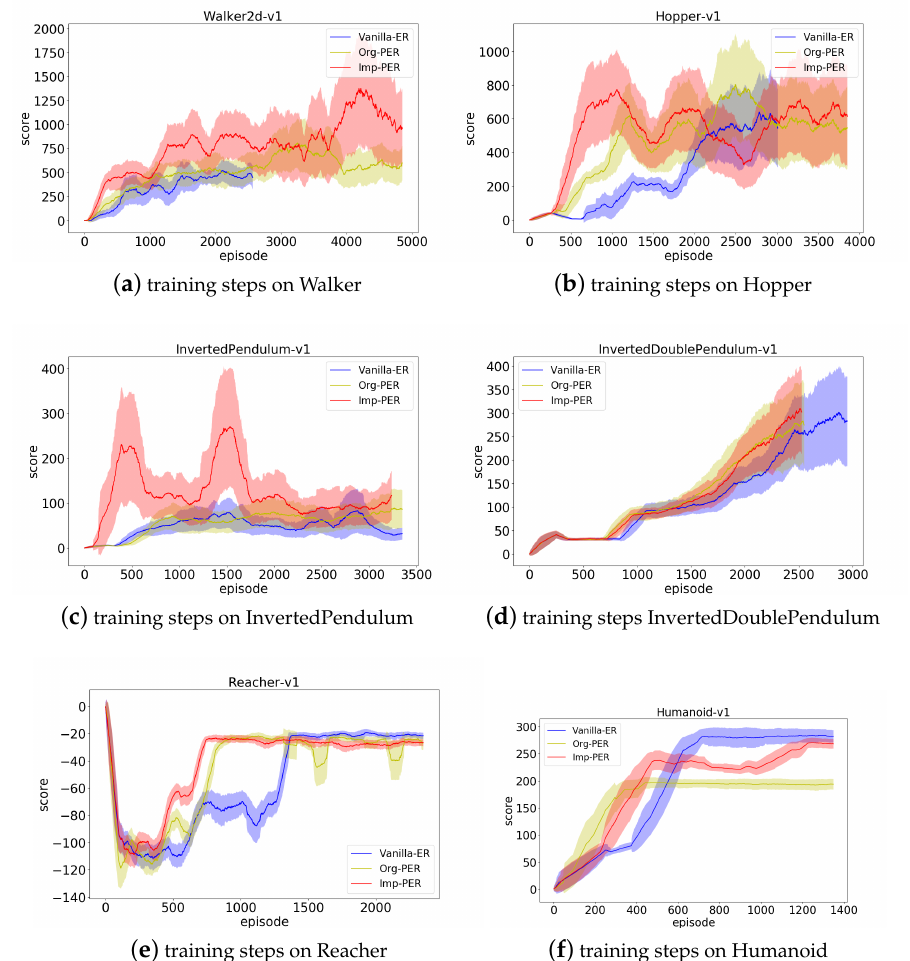
Figure 14. The performance compares on MuJoCo with DDPG. Each task is run five times using different random seeds until DDPG